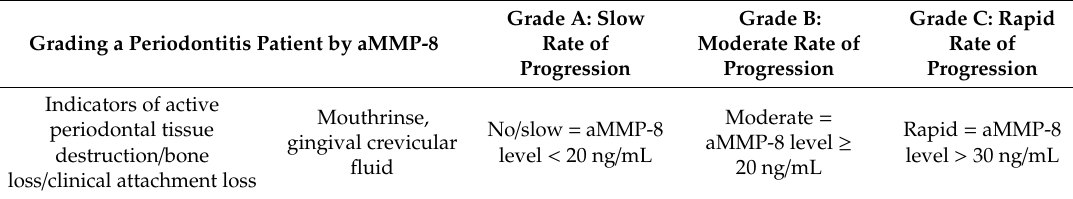
Table 2. Grading a periodontitis patient (modified from Tonetti et al. [1]) by active matrix metalloproteinase-8 (aMMP-8) as the main biomarker for active / progressing periodontal diseases. Grade A: Grading a Periodontitis Patient by aMMP-8